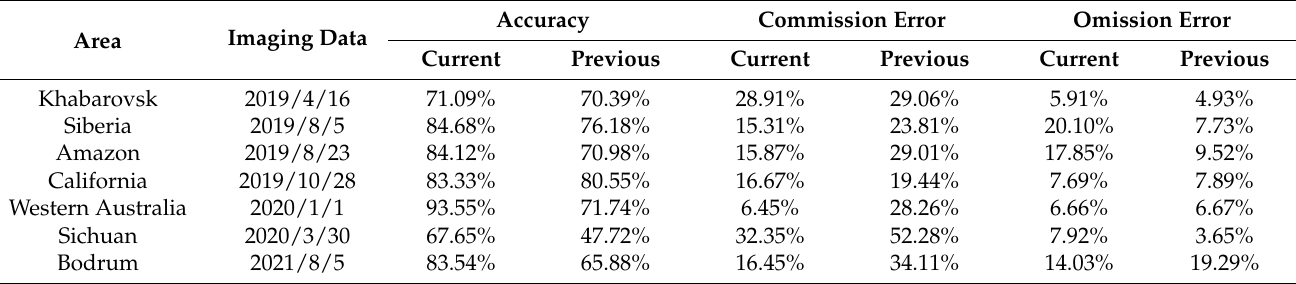
Table 2. Detailed statistical results of each fire detection algorithm compared with